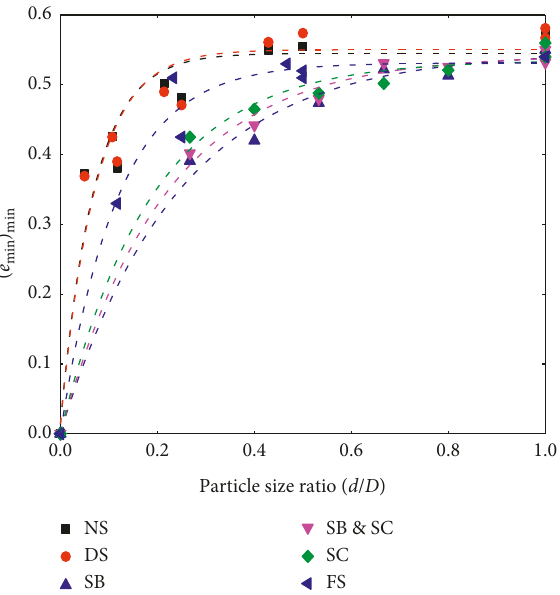
Figure 11: The relationship curves of ( e min ) min and d / D for the binary mixtures. Table 4: The fitting results of the relationship curve between ( e min ) min and d / D values.